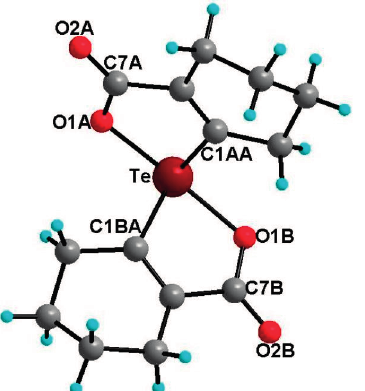
Figure 7. Molecular structure of compound 21 . Selected bond lengths (Å) and bond angles (°); Te–C1AA 2.055(1), Te–C1BA 2.138(12), Te–O1A 2.114(3), Te–O1B 2.082(3), O2A–C7A